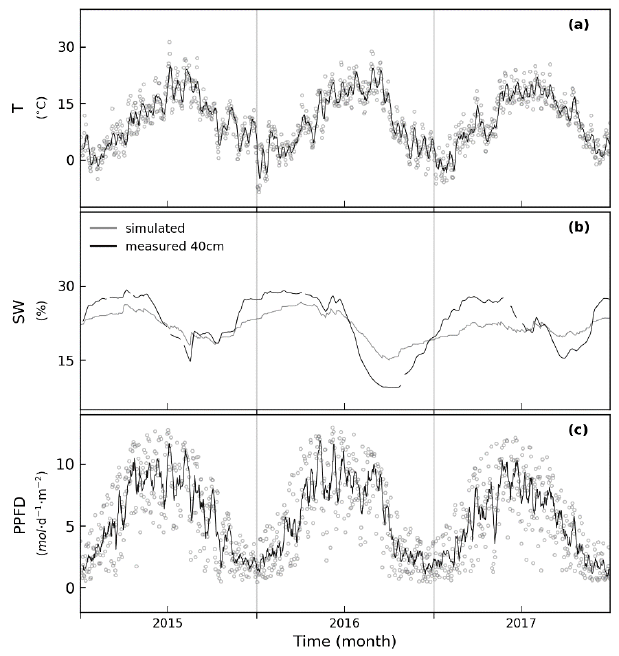
Figure A1. Daily measured ( a ) air temperature (T) in °C, ( b ) measured and simulated soil water content (SWC) in % and ( c ) photon flux density (PPFD) in µmol(photon) m 2 s −1 for 2015–2017 at the forest site Hohes Holz. Grey dots in ( a , c ) represent daily averages. The black lines ( a , b ) show running means of each variable (7 days). Temperature, precipitation and PPFD serve as input data for the forest model. In the FORMIND model the soil water content is computed per 20 m × 20 m patch and depends on precipitation, interception and run-off as well as on trees individual consumption (transpiration). The simulated soil water is slightly lower than the measured soil water content during winter time ( b ) and higher during drought events, e.g., in 2016. Table A1. Main abiotic variables measured at the EC tower in 33 m (air temperature), and 49 m (radiation and precipita- tion), and in 0.4 m soil depth (soil moisture) needed as input for the forest model FORMIND. Variable Measured Abbreviation Unit Instrument Type, Manufacturer SWD global radiation photosynthetic photon flux density